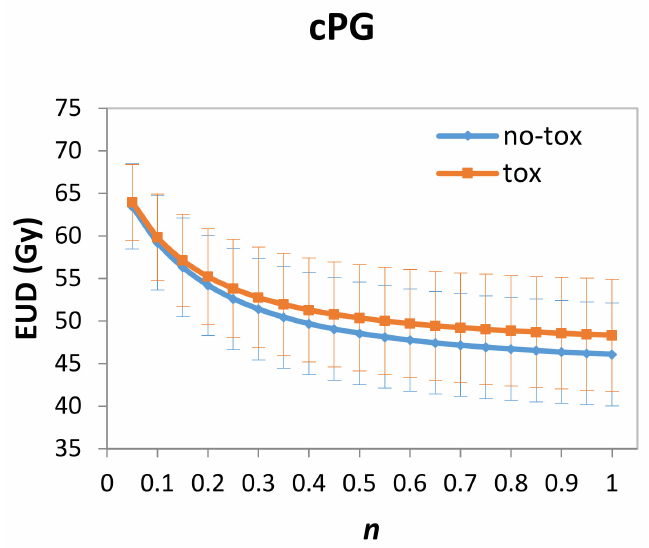
Figure A2. Average Equivalent Uniform Dose (EUD) and standard deviations for combined parotid glands (cPG) as a function of the volume parameter n used to calculate EUD. Results for patients with (red line, label “tox”) and without (blue line, label “no-tox”), where grade ≥ 2 acute salivary dysfunction are reported. There are no statistically significant differences ( t -test) in EUD in the two